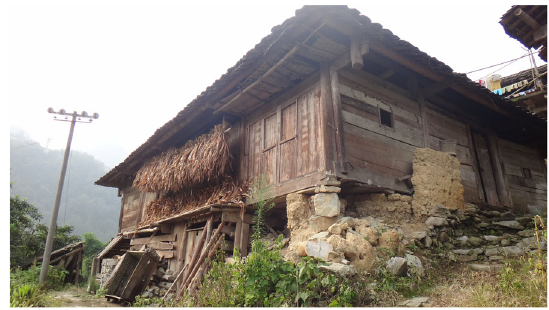
Fig. 8 Appearance of type-A house in Shuifu Village (Source: the